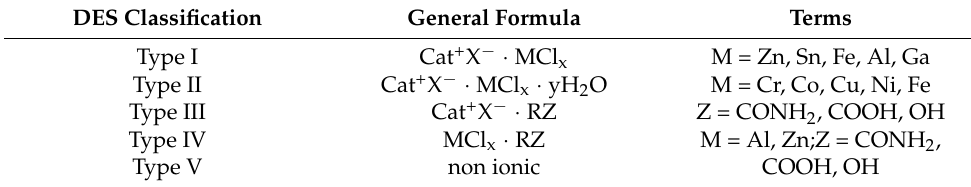
Table 1. Classification of deep eutectic solvents. DES Classification General Formula